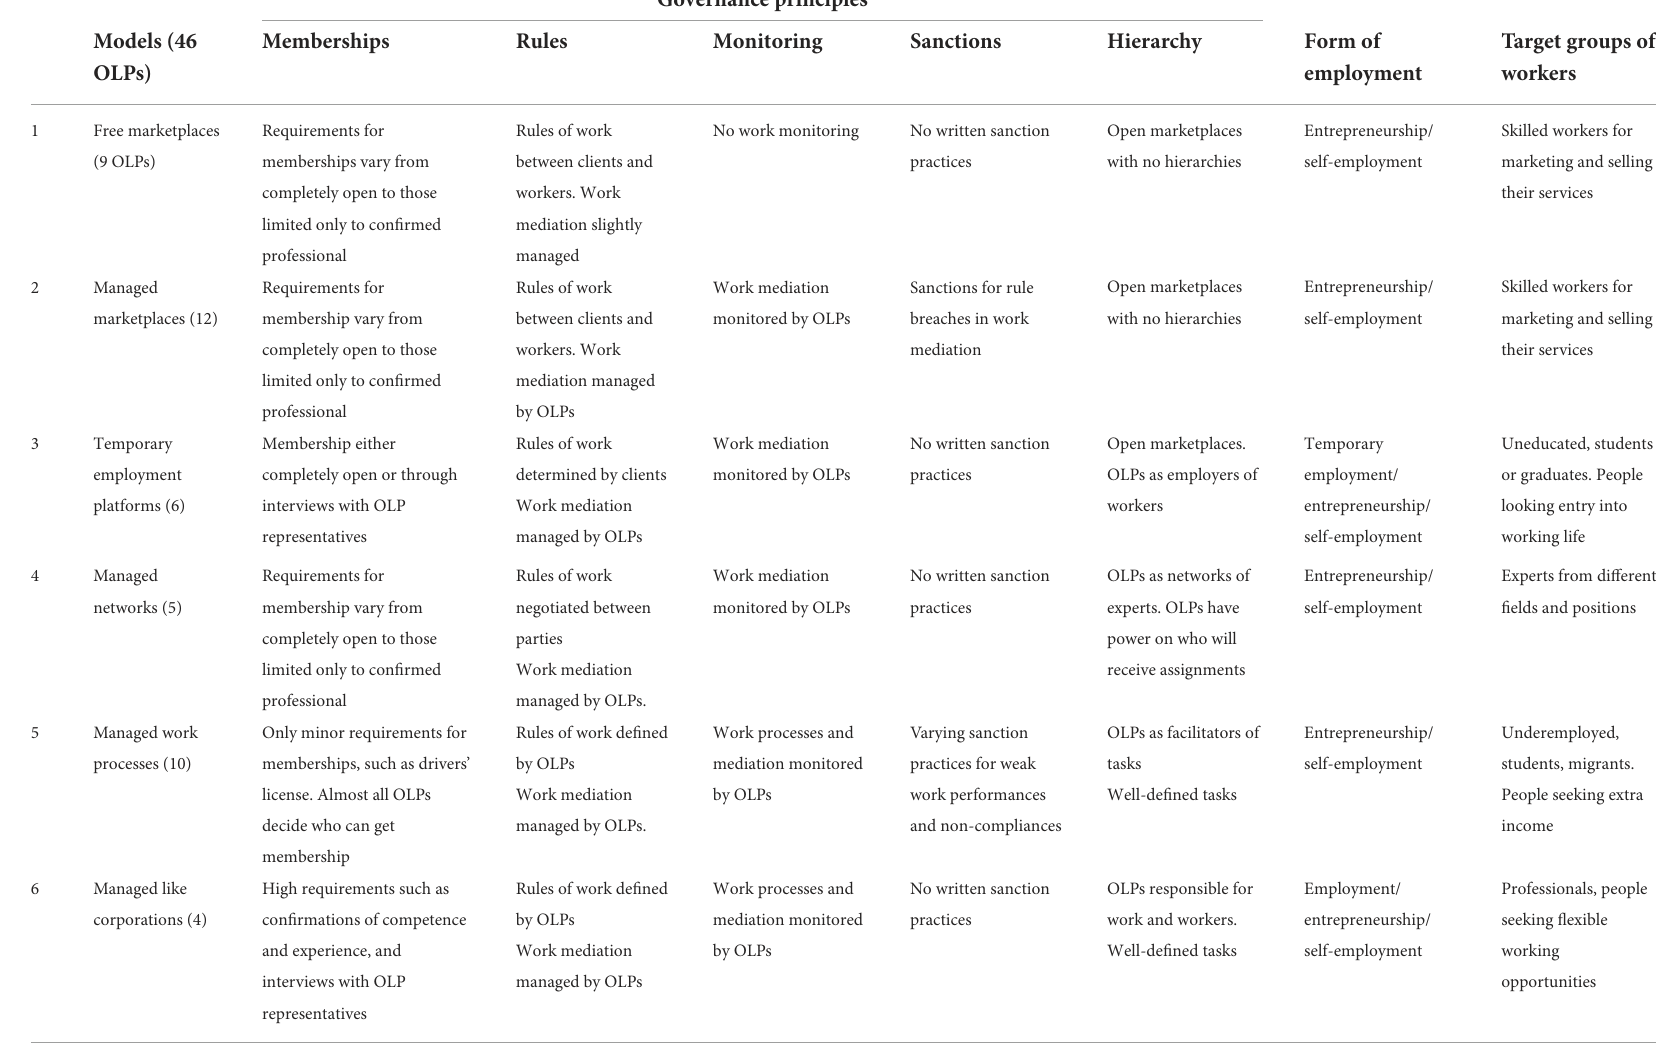
TABLE 2 OLPs’ human resource management (HRM)